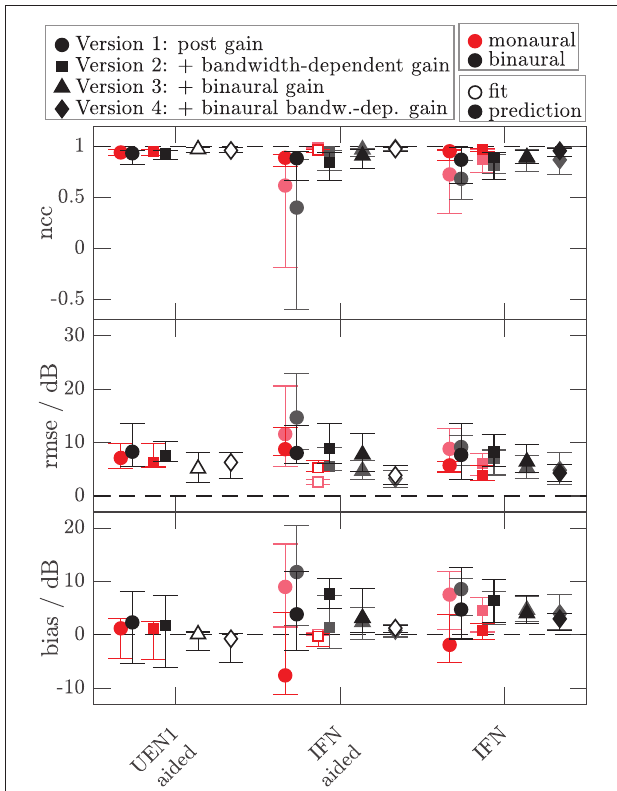
FIGURE 9 | As Figure 8 but for the additional data of 10 HI listeners of Dataset 2. Performance measures from Figure 8 are replotted in brightened colors if measurement conditions are comparable. In contrast to Figure 8 , the performance measures for the monaural narrowband LNN stimuli are not shown. Binaural or diotic data are not available for the LNN stimuli. Instead, the loudness data of the aided UEN1 stimulus were used to fit the parameters of the binaural